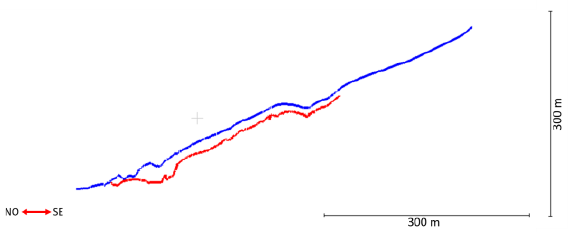
Figure 13. Comparison between 2014 DPCs (in blue) and 2016 DPC (in red) along Section 1.